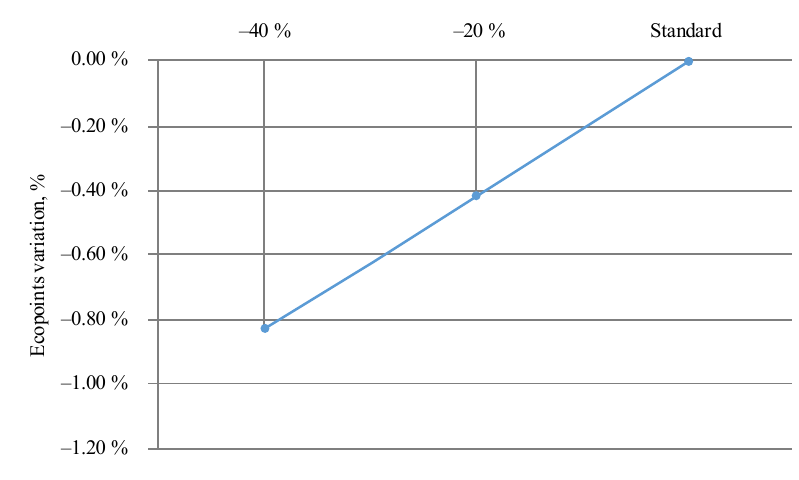
Fig. 7. Sensitivity analysis graph relating to the variation of the electrical